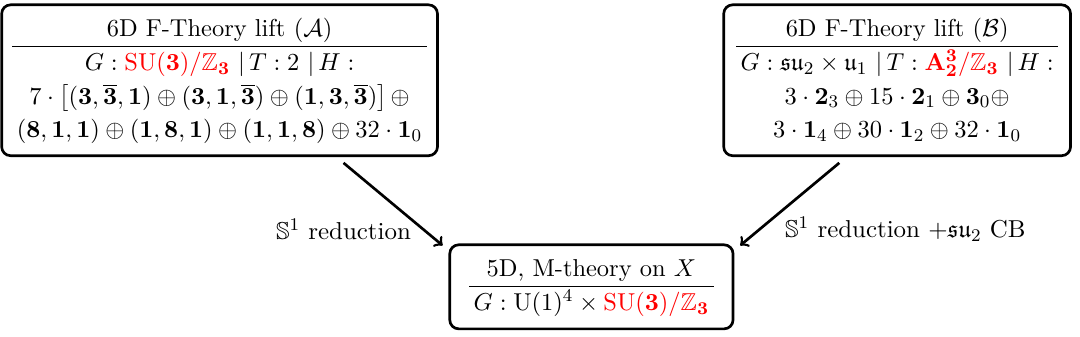
Figure 5 . Depiction of M-theory on X with U(1) 4 × SU(3) / Z 3 gauge group, that exhibits two different 6D F-Theory lifts and their massless spectra. Lift ( A ) exhibits an SU(3) / Z 3 non-simply connected gauge group in 6D. The former center symmetry becomes a gauged 2-form symmetry of the A 3 SCFT sector in the second lift 6D lift ( B ) 2